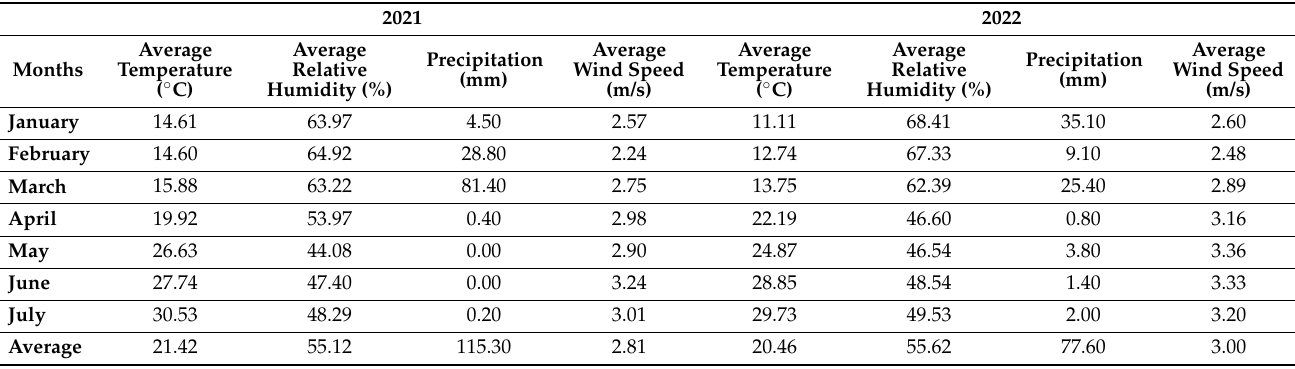
Table 3. Climate classification and climate data during the 2021–2022